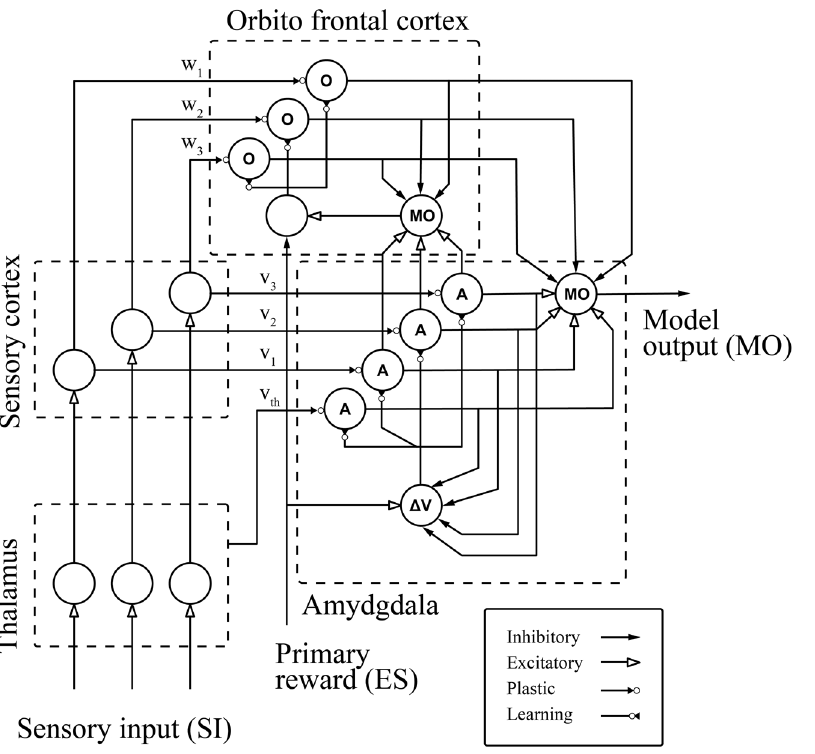
Figure 7. A graphical depiction of the brain emotional learning process 8